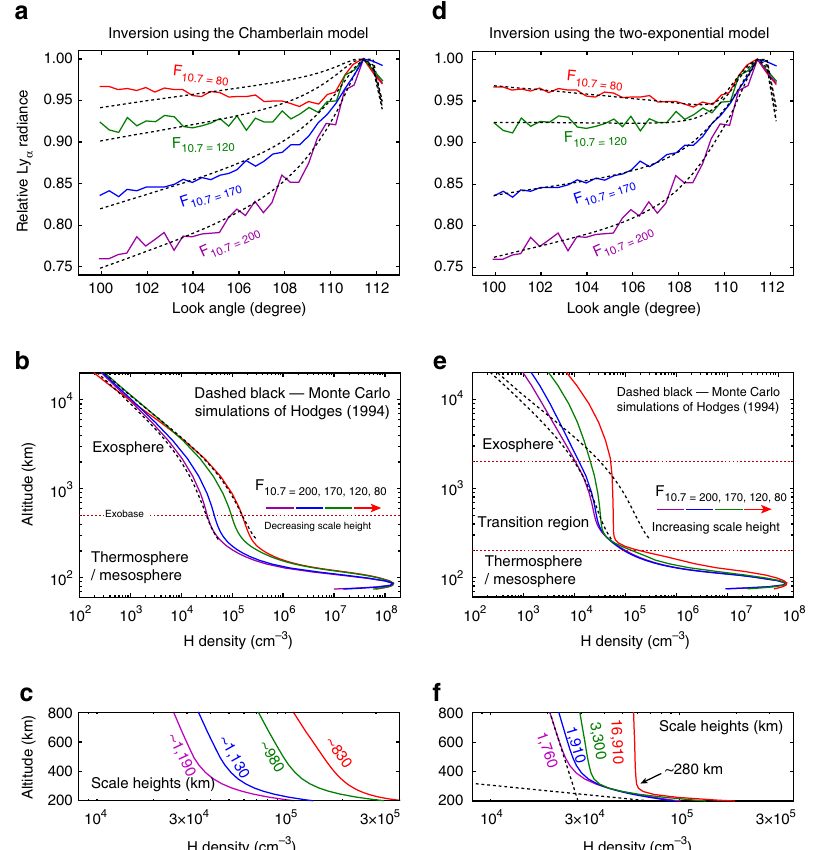
Figure 2 | Inversion of the observed Ly a radiances. ( a – c ) Inversion using the Chamberlain model as the physical constraints. ( d – f ) Inversion using the two-exponential model as the physical constraints. In a , d the solid-coloured lines represent the observed Ly a radiances associated with different levels of solar activity: (red) F10.7 ¼ 80; (cyan) F10.7 ¼ 120; (blue) F10.7 ¼ 170; and (purple) F10.7 ¼ 200, and the dashed-black lines are the modelled radiances corresponding to the best-fit cases in the least squares sense. In b , e , the dashed-black lines represent the previous Monte Carlo simulation results under solar maximum and minimum conditions 13 . The solid-coloured lines are the hydrogen density profiles retrieved from the corresponding radiance data in a , d using ( b ) the Chamberlain model and ( e ) the two-exponential model as the physical constraints. ( c , f ) Zoom-in views of the hydrogen density profiles from b , e . The estimated scale heights in c are controlled by the ambient temperature specified by the NRLMSISE-00 model, which are 1,232, 1,146, 974 and 809K, respectively. The temperature corresponding to the scale heights shown in f are calculated to be 2,093, 2,271, 3,923 and 20,116K assuming hydrostatic equilibrium. It should be noted that the condition of hydrostatic equilibrium is not fulfilled in the upper thermosphere for the hydrogen population, thus the scale height–temperature relationship is not linear. The temperatures calculated based on the scale heights of f serve only to contrast the inferred climatological behaviour and that specified by the NRLMSISE-00 model. The two dashed-black lines in f represent the exponential functions of the cold and the hot populations under solar maximum